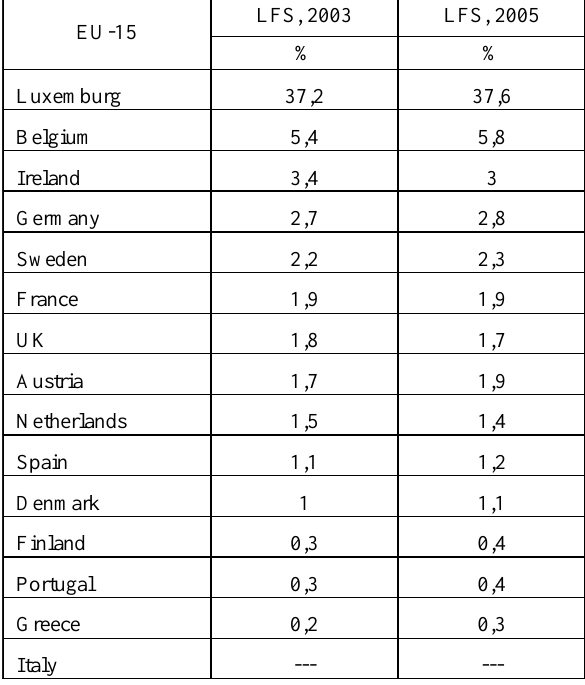
Table 7. Other EU-15 nationals as a